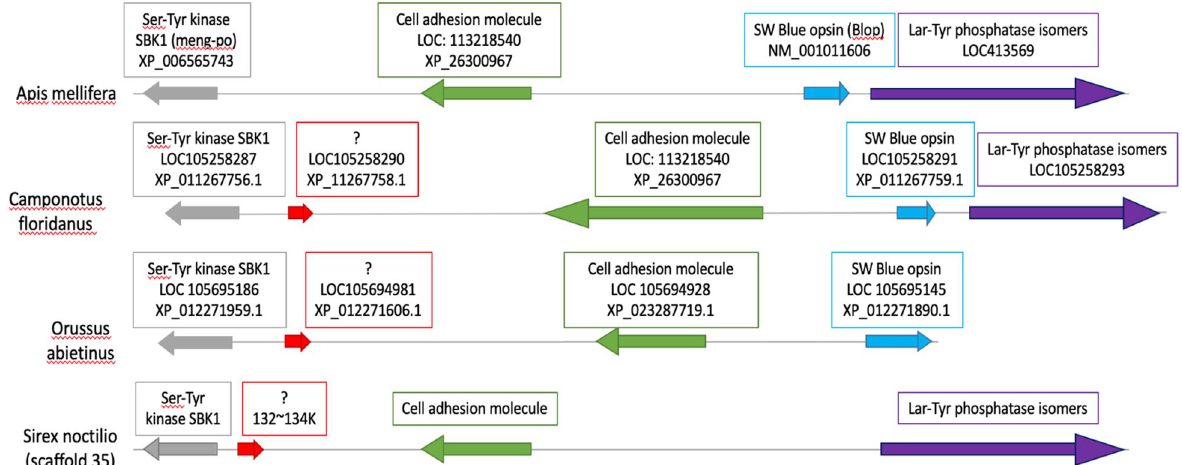
Figure 3. Representation of the SW flanking gene in three hymenopterans. Similar colour corresponds to orthologs. The SW opsin gene in A. mellifera , O. abietinus and C. floridanus is flanked by the Cell adhesion molecule (green) gene and the Lar-Tyr phosphatase (purple) genes, also found in S.